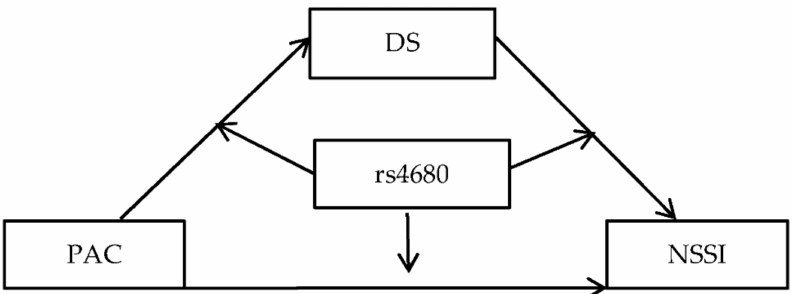
Figure 1. Hypothesized research model Note: DS = depressive symptoms, PAC = parent-adolescent conflict, NSSI = non-suicidal